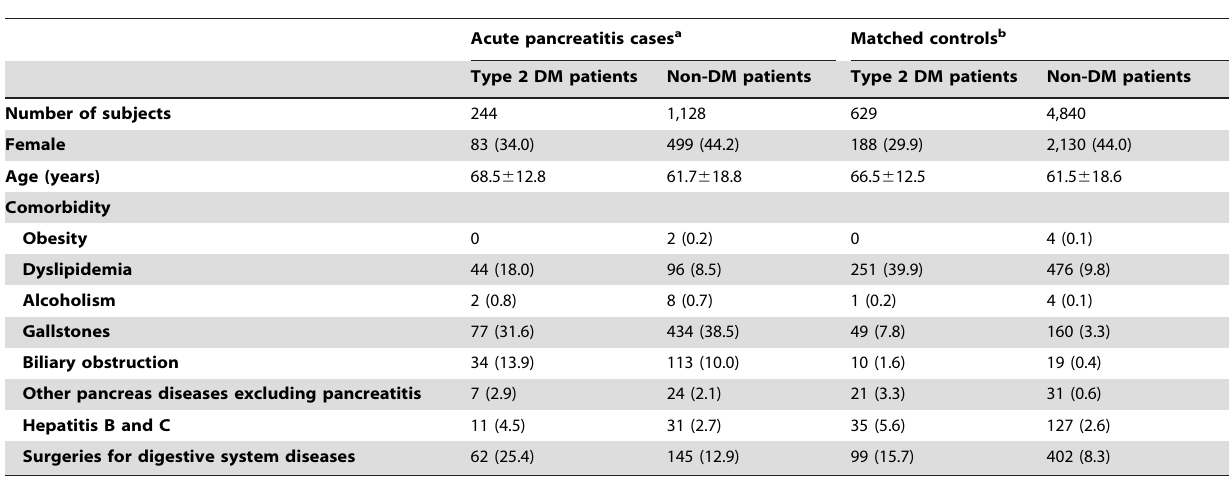
Table 3. Baseline characteristics in case-control substudy.